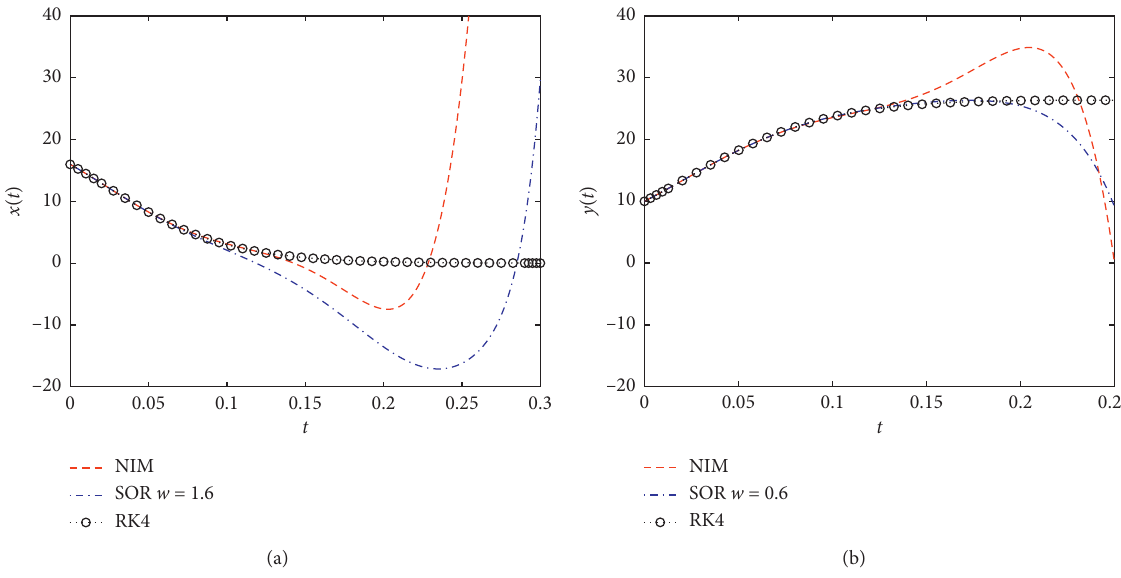
Figure 4: Case 2: comparison of three-term approximation SOR-like new iterative method, NIM, and RK4 for x ( t ), y ( t ), and ω .